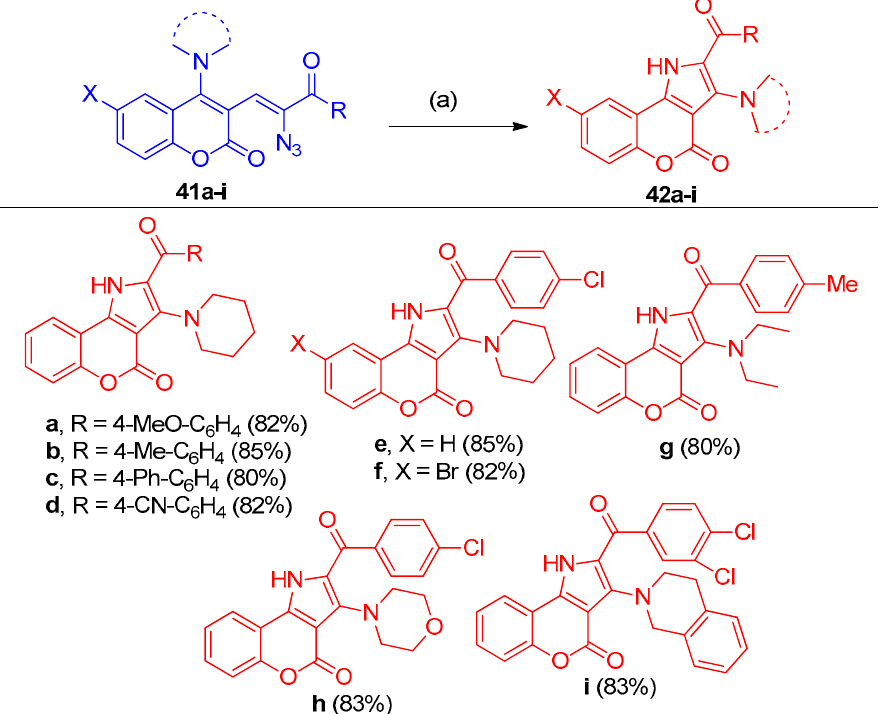
Scheme 23. Optimized reaction condition of the decomposition of vinyl azide 41a .